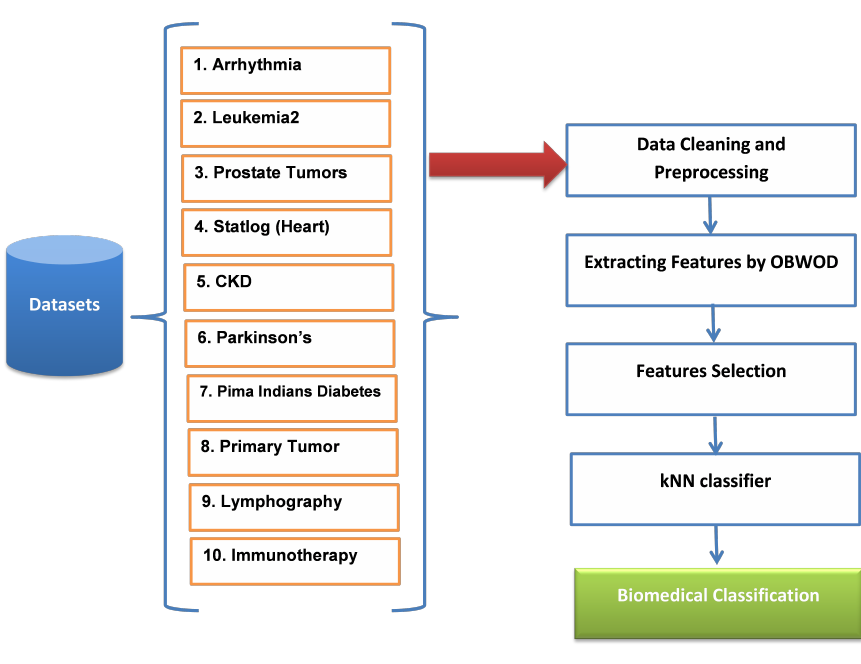
Figure 2. The process of classifying medical